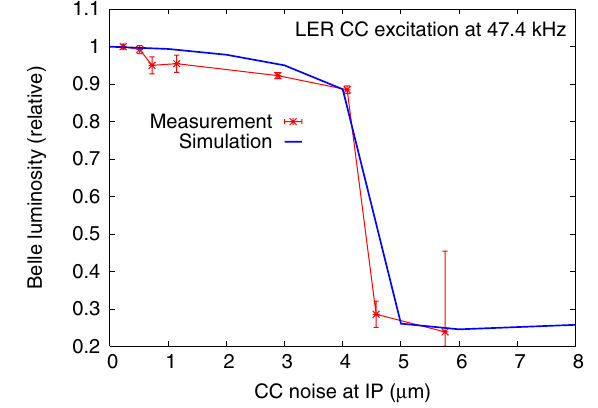
FIG. 2. Luminosity versus LER crab-cavity noise as extrapo- lated to IP displacement. The excitation frequency (0.523 in tune units) is close to the LER horizontal tune. The LER IP nominal horizontal beam size is 160 (cid:3) m